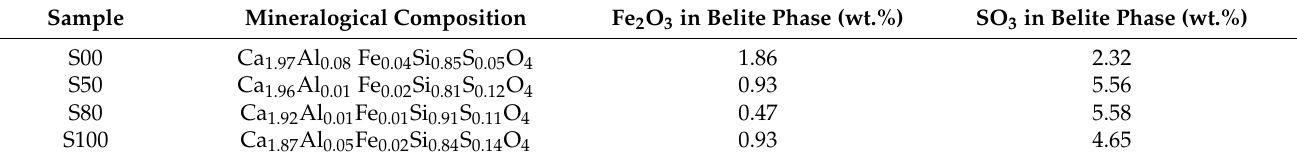
Table 5. Mineralogical composition of belite phase of samples S00, S50, S80 and S100. Sample Mineralogical